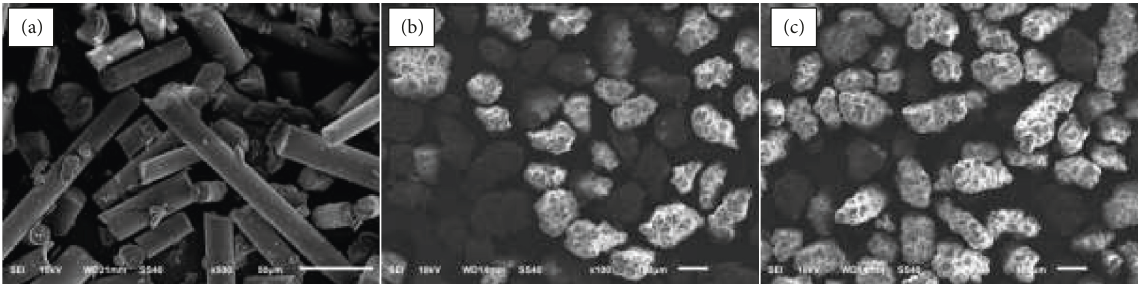
Figure 2: Representative SEM images (x100, x500 magnification) showing (a) short E-glass fiber, (b) ultra-high-molecular-weight polyethylene filler particles after surface modification, and (c) ultra-high-molecular-weight polyethylene filler particles before surface